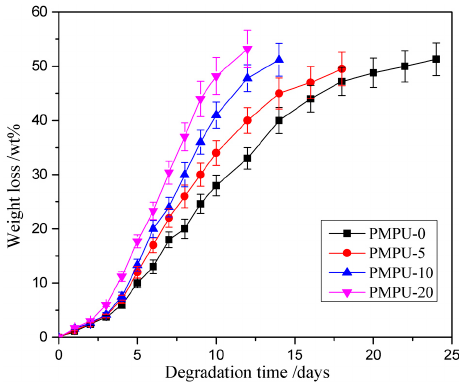
Figure 4. Weight loss curves of composite films with varying PMEH content in PBS (pH = 7.4) at 37 ± 0.1 °C.